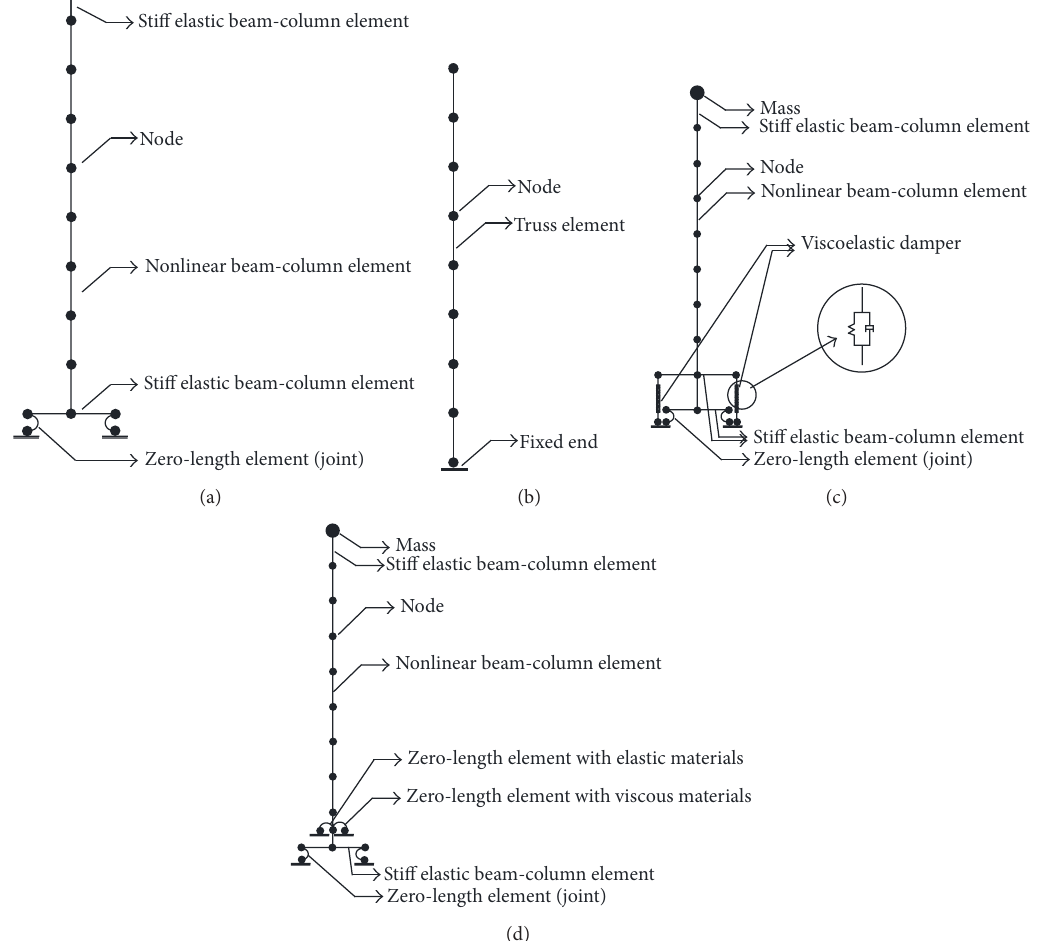
Figure 3: Schematic analytical model of the hybrid system: (a) column of common self-centering pier; (b) tendons; (c) pier with viscoelastic damper with longitudinal direction deformation; (d) pier with viscoelastic damper with transverse direction